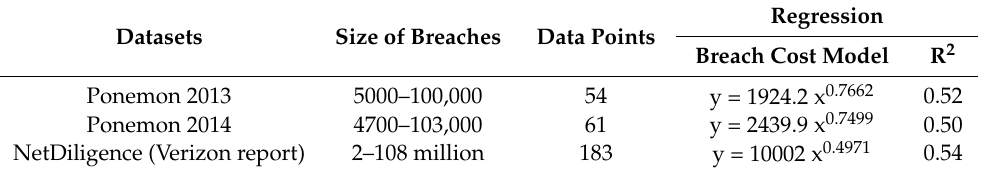
Table 2. The breach cost regression models for the three datasets.